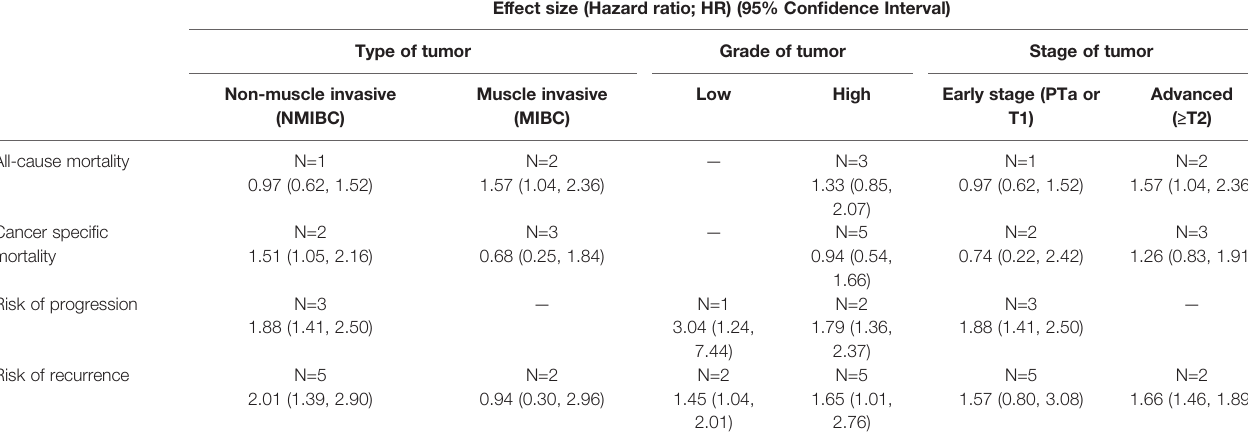
TABLE 3 | Subgroup analysis for bladder cancer outcomes in obese patients relative to normal